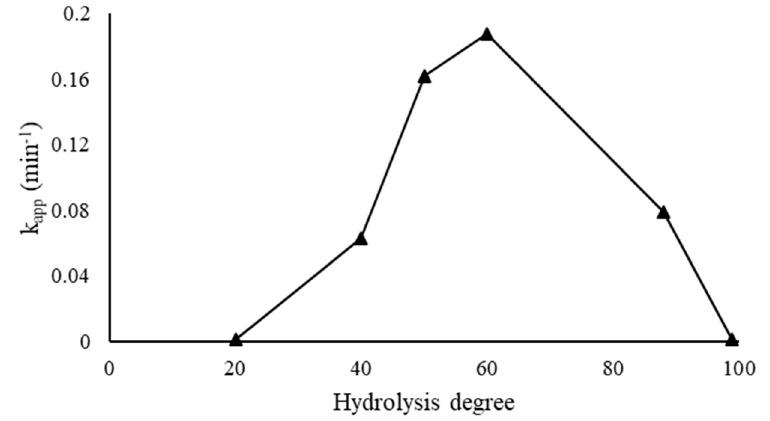
Figure 5. Volcano plot for the effect of PVA hydrolysis degree on the catalytic activity, reaction carried out using 25 mL of 4–NP (2 × 10 − 4 M), 25 mL of NaBH 4 (9.0 × 10 − 3 M), an Au/PVA weight ratio of 1:0.65, 4 mg of catalyst, at 25 ◦ C.